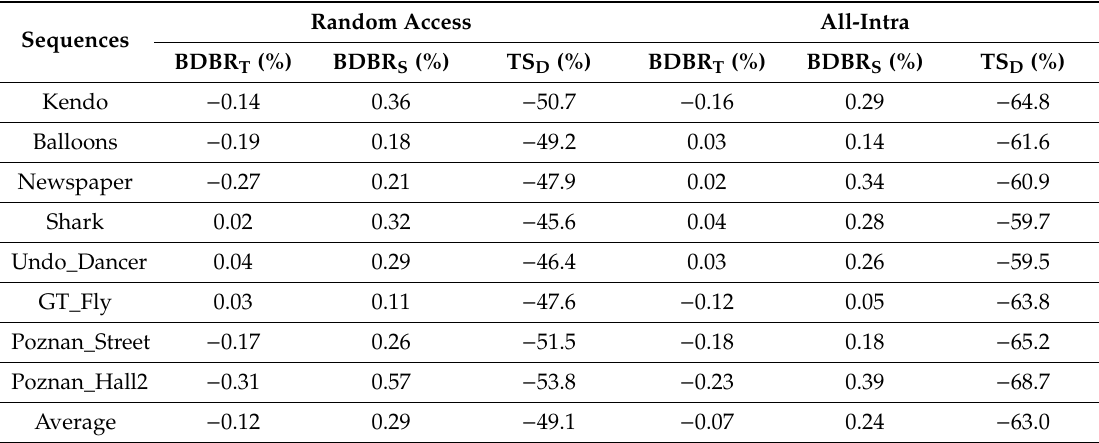
Table 8. Coding results of the proposed